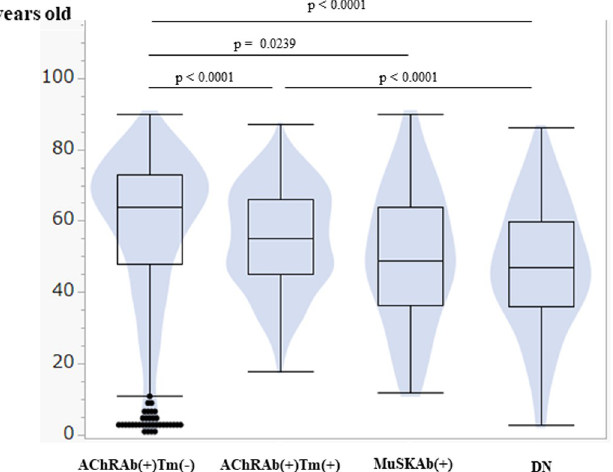
Fig 3. Onset age by categories. Box plot and violin plot of onset age by categories. The horizontal line within the box represents the median value. The box ends to define the 25th and 75th quantiles, expressed as the first and third quartiles. The lines that extend from the box end are whiskers. The whiskers extend from the ends of the box to the outermost data point that falls within these distances. 1st quartile–1.5 x (interquartile range), 3rd quartile+1.5 x (interquartile range). For statistical analysis, Steel-Dwass All Pairwise Comparison was performed.